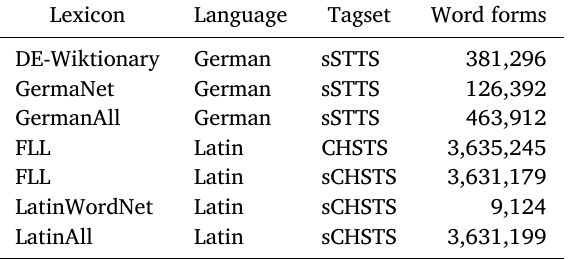
Statistics of lexica